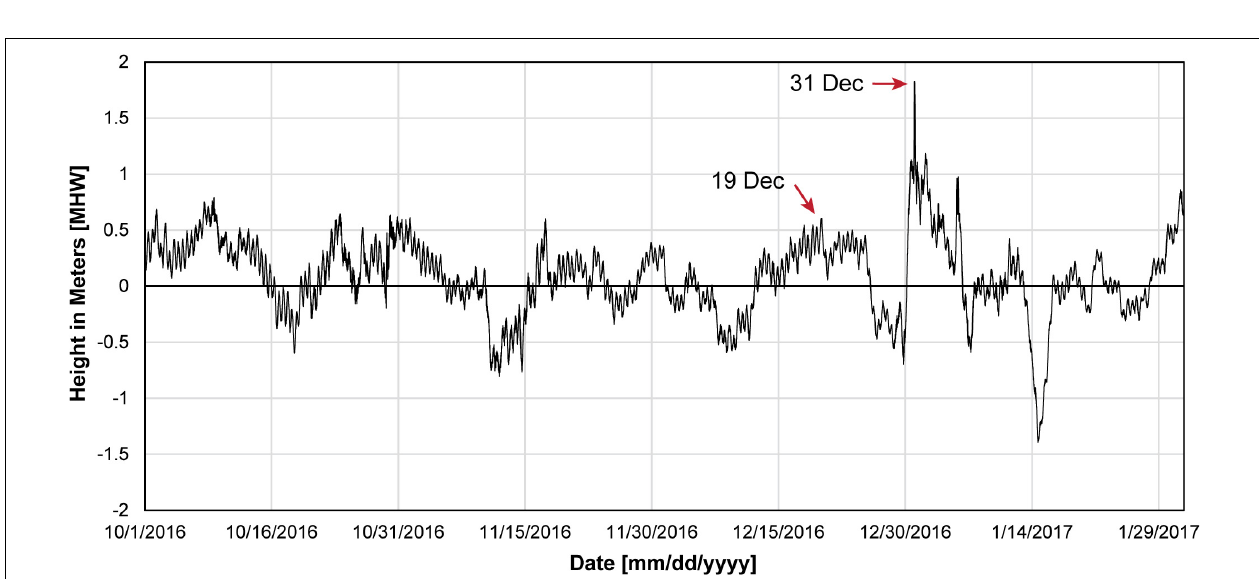
FIGURE 5 | Water-level data for NOAA tide station 9491094 at the Red Dog Dock, located 115 km to the north of Cape Espenberg, between 1 October 2016 and 31 January 2017. Water levels are shown in meters relative to mean high water (MHW), the average of all the high water heights at the station observed over the current national tidal datum epoch (NTDE) (1983–2001). The 31st December surge is the second largest recorded since the station began operation in August 2003 (National Oceanic and Atmospheric Administration [NOAA], 2020).